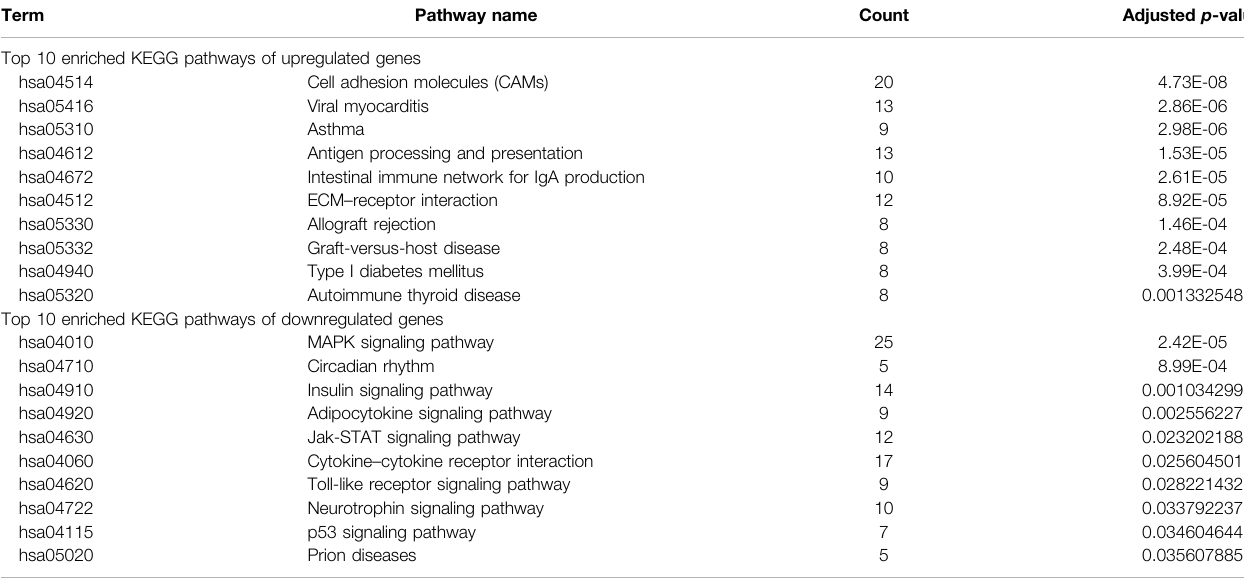
TABLE 2 | Top 10 enriched KEGG pathways of upregulated and downregulated expressed genes. Term Pathway name Count Adjusted p -value Top 10 enriched KEGG pathways of upregulated genes